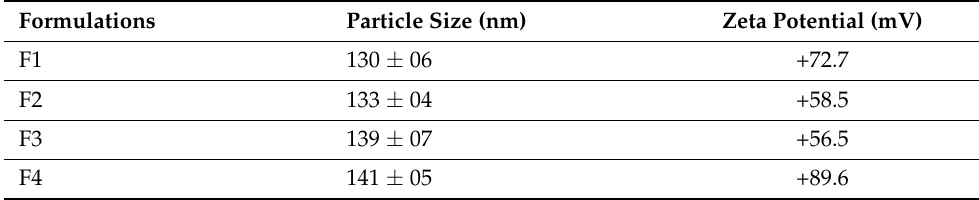
Table 1. Zeta size analysis of the prepared nano-emulsion, describing the nano-sized ranged formulation.